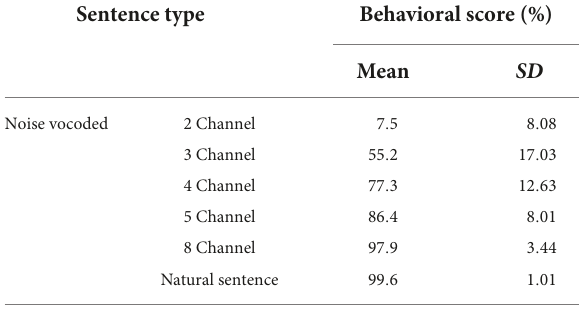
TABLE 3 Comparison of the performance of deep learning models using event-related potentials (ERP), stimuli envelopes (ENV), phonemes (PH), and phoneme-envelopes (PHENV).